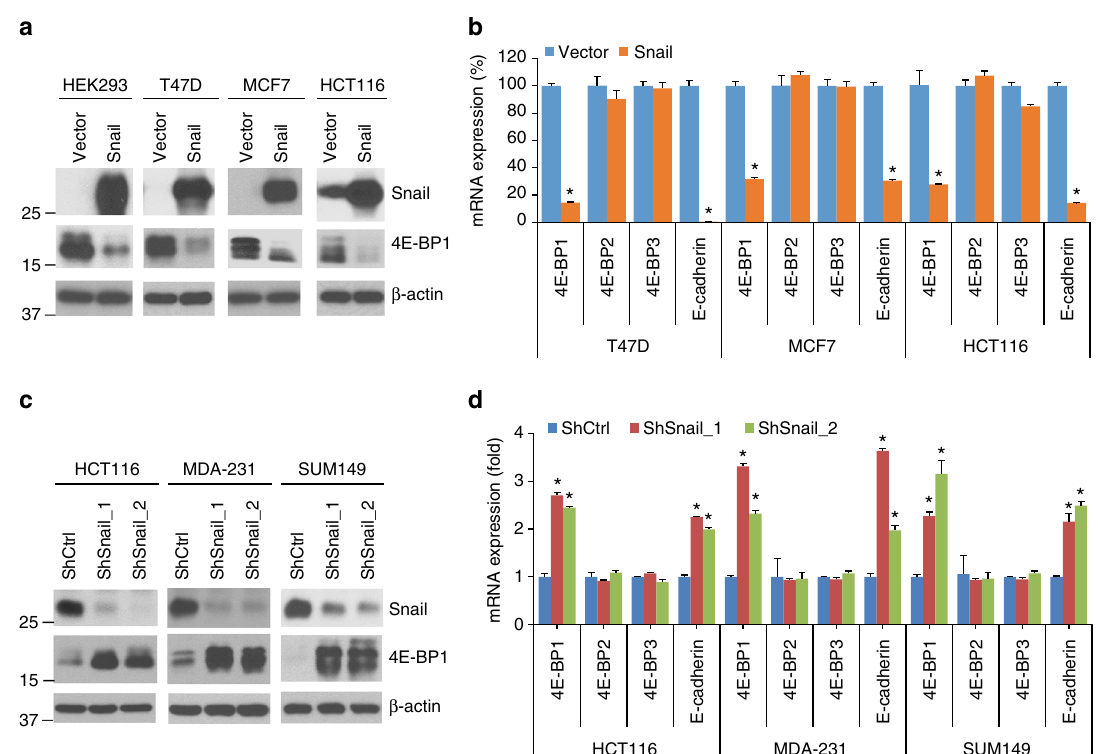
Fig. 2 Snail represses 4E-BP1 expression at both the protein and mRNA levels. a HEK293, T47D, MCF7, and HCT116 cells with stable expression of Snail or vector control were analyzed by western blotting for the indicated proteins. b mRNA expression of the indicated genes was analyzed by quantitative RT- PCR in T47D, MCF7, and HCT116 cells with stable expression of Snail or vector control. The indicated gene expression was normalized against GAPDH and presented as a percentage of the expression level found in vector control cells. c HCT116, MDA-231, and SUM149 cells with stable expression of two different sets of Snail shRNAs (ShSnail_1 and ShSnail_2) or control shRNA (ShCtrl) were analyzed by western blotting for the indicated proteins. d mRNA expression of the indicated genes was analyzed by quantitative RT-PCR in HCT116, MDA-231, and SUM149 cells with stable expression of ShSnail_1, ShSnail_2, or ShCtrl. The indicated gene expression was normalized against GAPDH and presented as a fold increase over the expression level found in ShCtrl cells. All graphic data are presented as mean ± SEM ( n = 3 technical replicates per condition). * P < 0.001 for Snail vs. vector or ShSnail vs. ShCtrl using Student's t -test